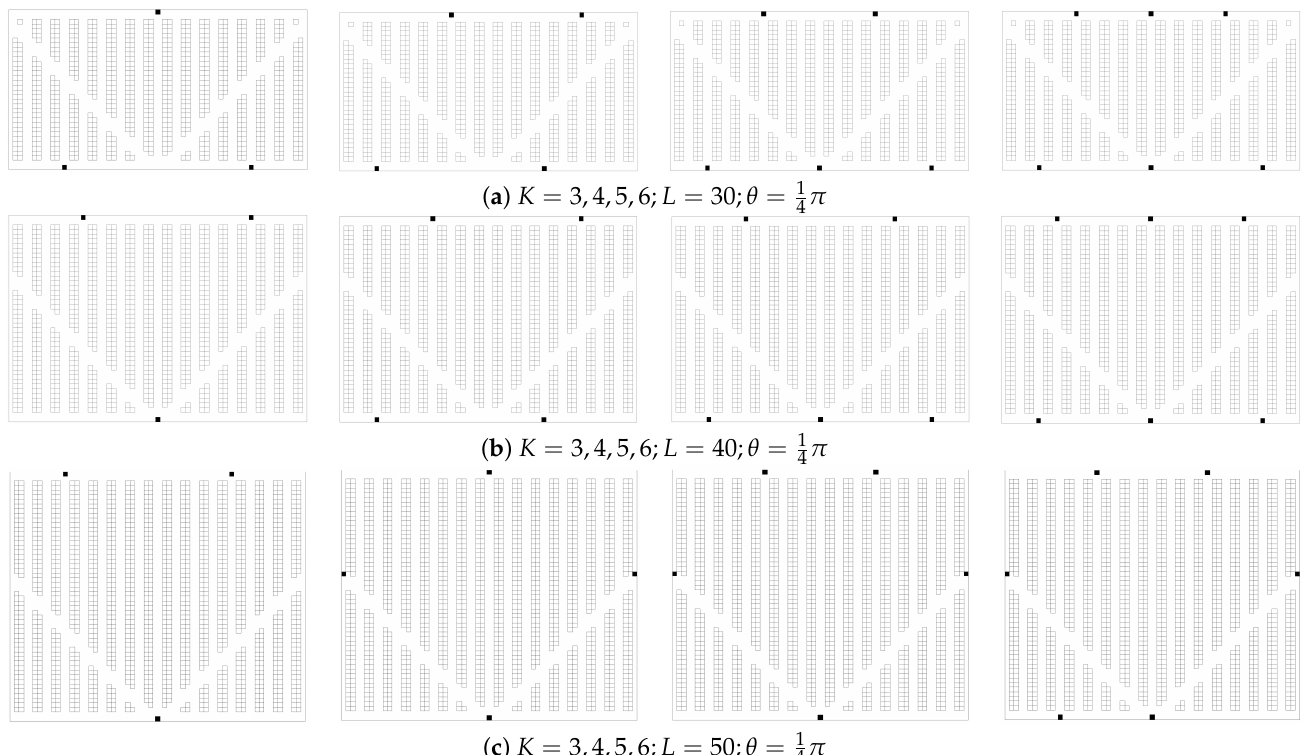
Figure 10. Optimal flying-V warehouse layout with different number of